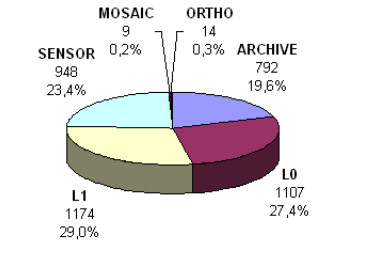
Figure 11- ICC Products requests distribution (Jan, Feb 2012) PLEIADES ground segment and image processing software